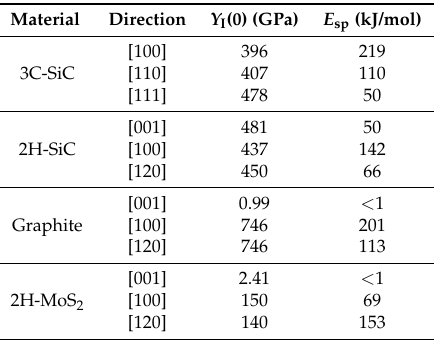
Table 3. Energy and Young modulus parameters from the integrated stress–strain SEOS